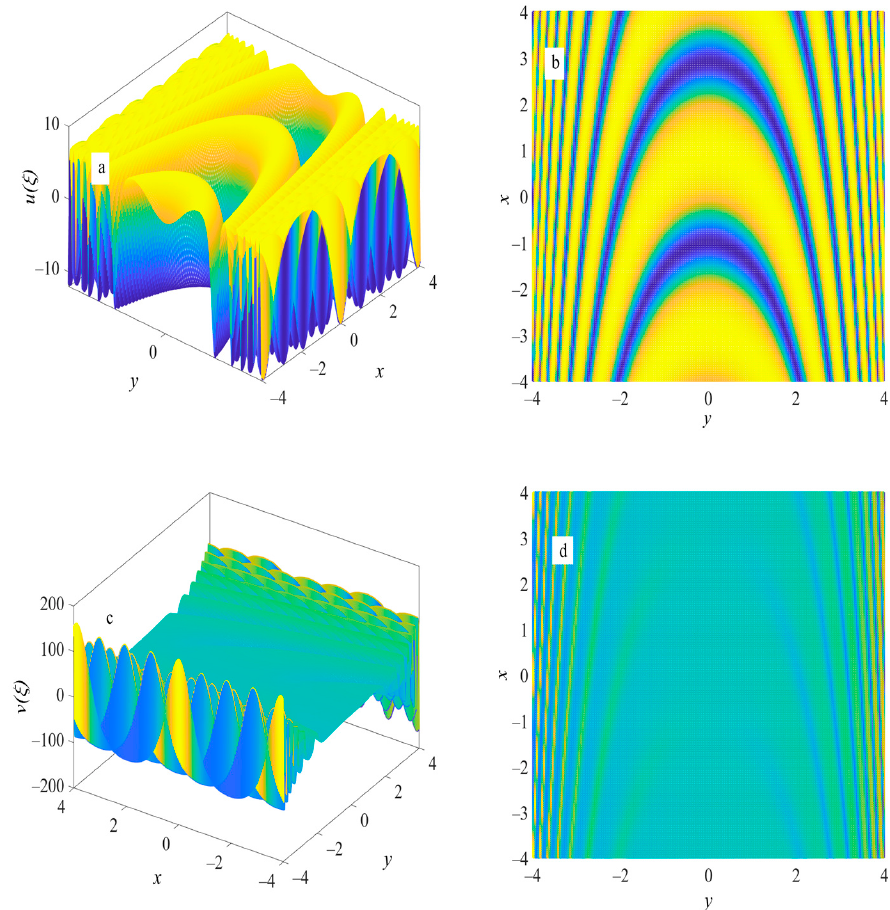
Figure 3. ( a ) Three-dimensional and ( b ) two-dimensional contour plots represent the horseshoe-type wave solution of Equation (35) and ( c ) three-dimensional and ( d ) two-dimensional contour plots represent the complex wave solution of Equation (36) when 𝑘 = 2, 𝑚 = 0.6, 𝜆 = 1, 𝑡 = 1 and 𝜔 = 16 .